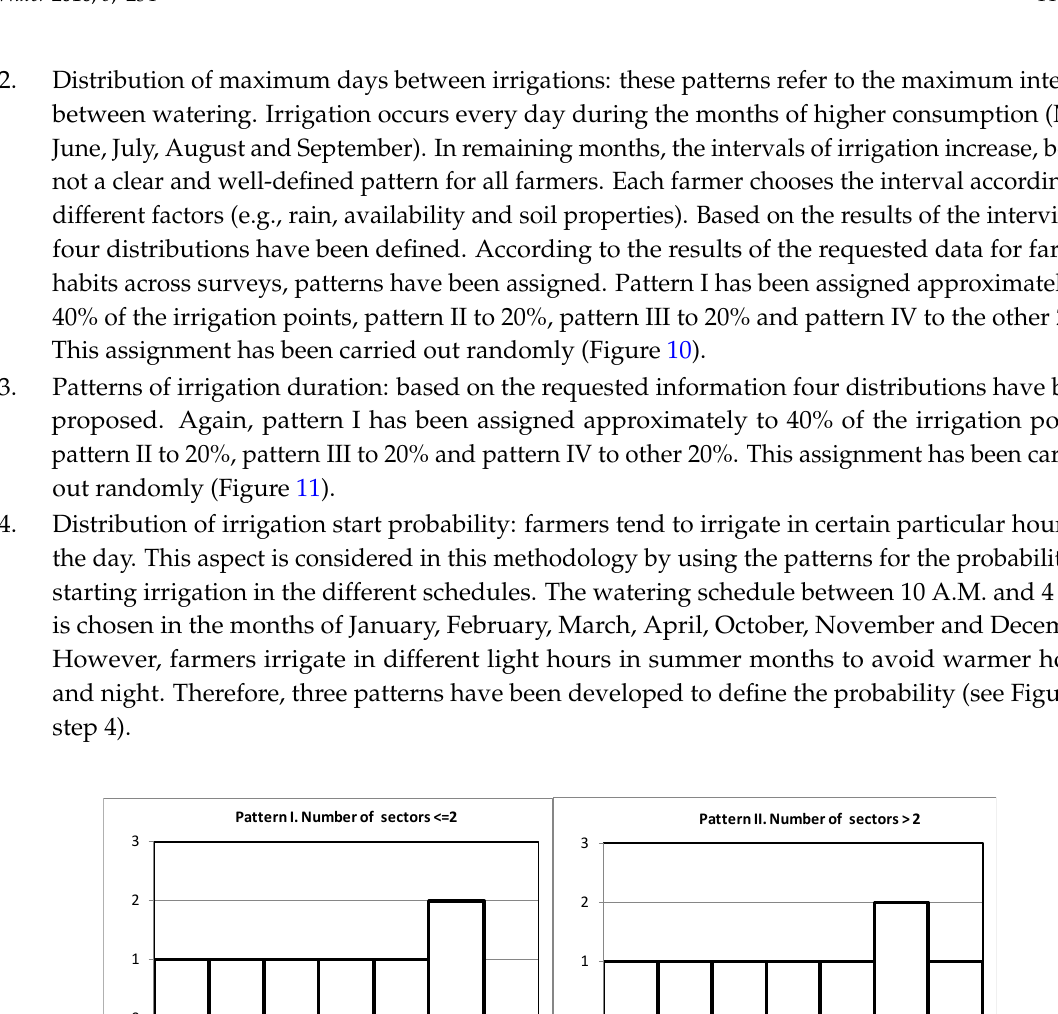
Water 2016 , 8 , 234 14 of 25